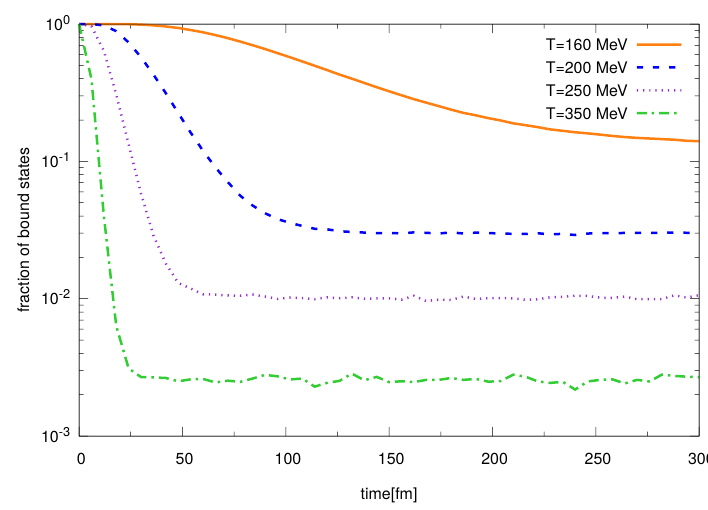
Figure 6. Time evolution of the fraction of bound states for different temperatures. Higher temperatures lead to a less amount of bound states and to a faster equilibration.